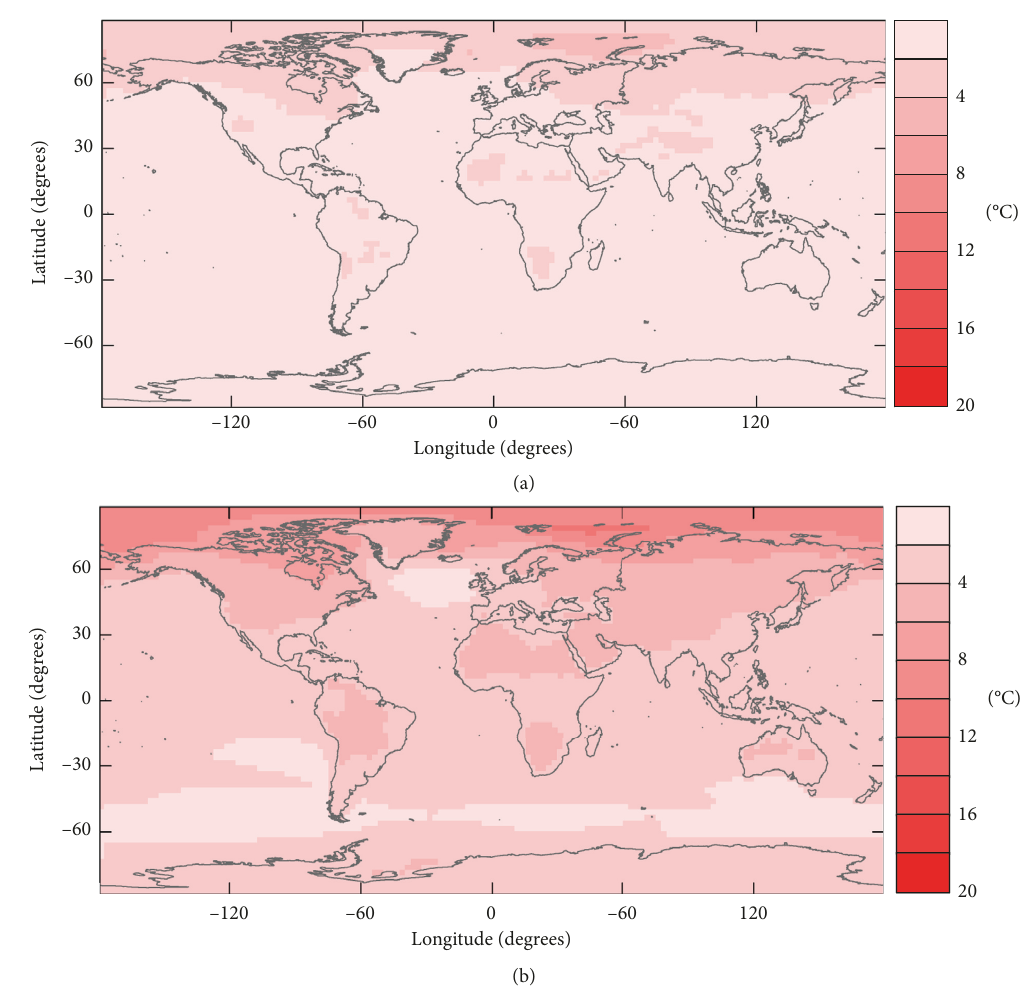
Figure 5: Simulated model mean temperature changes in response to Intended Nationally Determined Contribution (INDC) emissions for unconditional pledges in (a) 2030 and (b) 2100. The temperature anomalies are relative to preindustrial levels. The simulation data from 12 CMIP5 models were used to produce an average state of warming pattern for INDC (see Section 2.3). The 2030 spatial pattern for INDC was estimated based on RCP 4.5 scenario experiment due to the similar emission levels of RCP 4.5 and INDC for 2030. The 2100 spatial pattern for INDC was estimated based on RCP 6.0 and 8.5 scenarios experiments due to the available simulations of the two scenarios for larger temperature